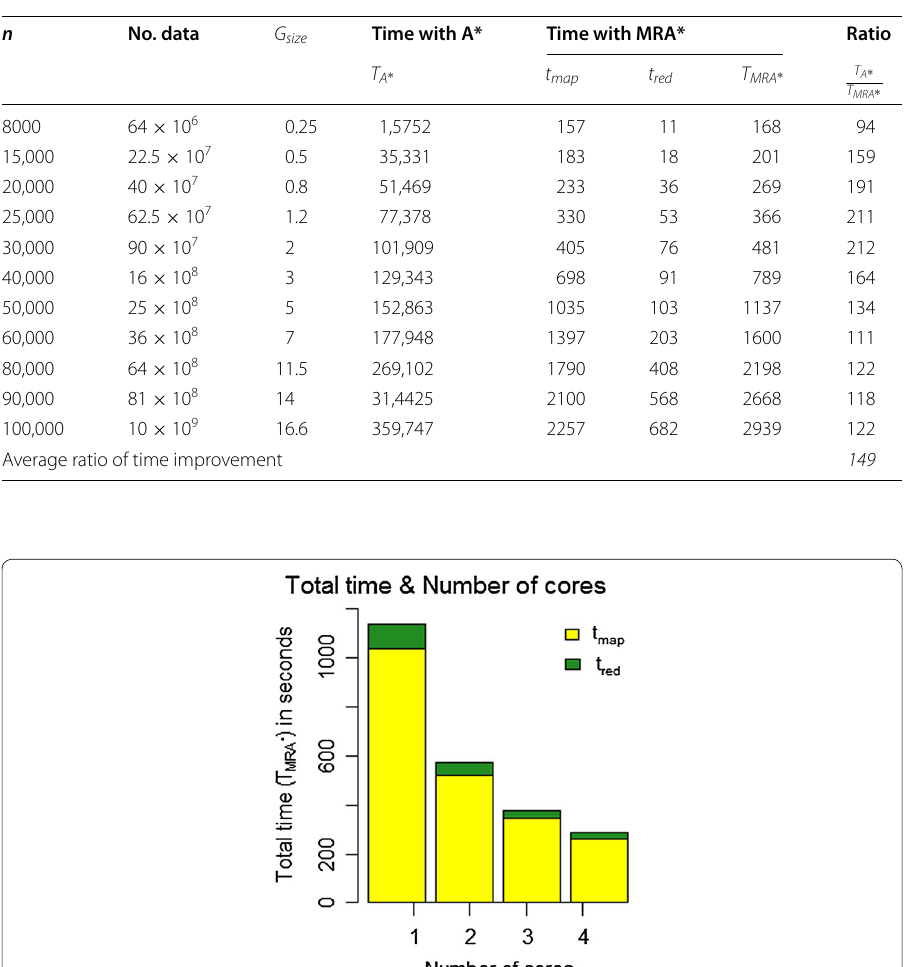
Table 3 Comparison of computational time in seconds time between A ∗ and MRA ∗ into a 1-node cluster